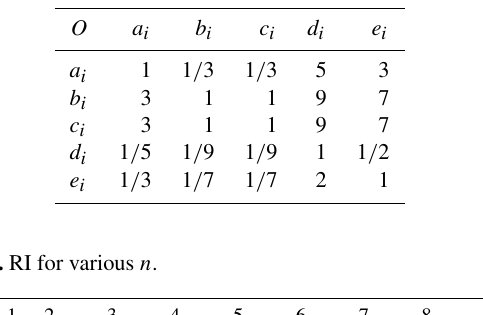
Table 1. Judgment matrix.